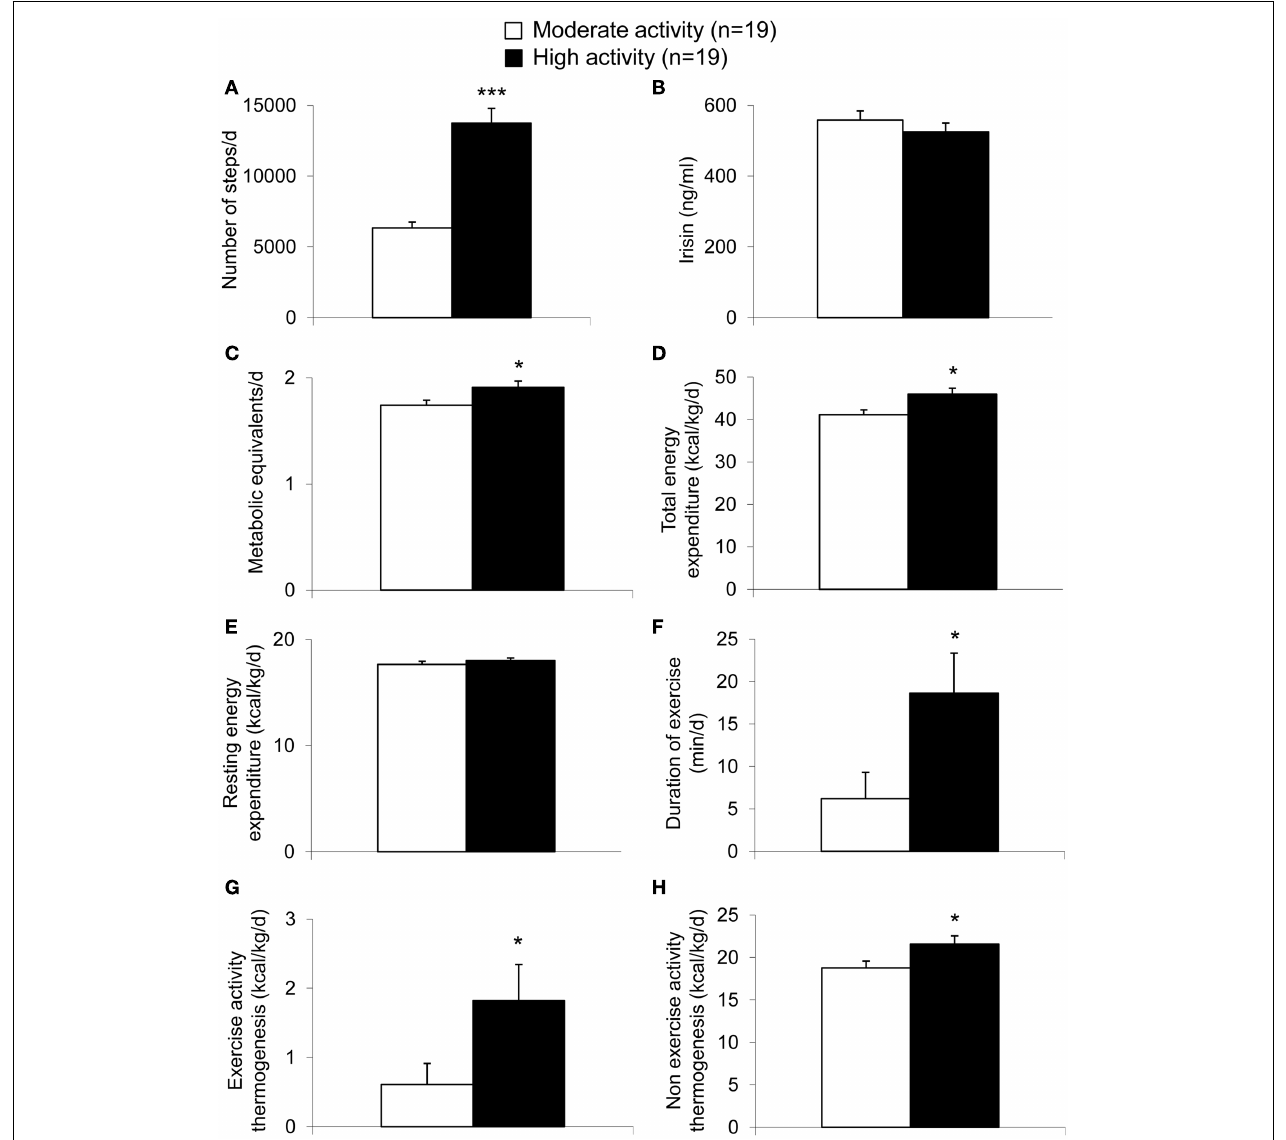
group, while no differences were observed for body weight-adjusted resting energy expenditure (E) . Duration of exercise (F) , body weight-adjusted exercise activity thermogenesis (G) , and body weight-adjusted non-exercise activity thermogenesis (H) were higher in the high compared to the moderate activity group. Data are expressed as mean ± SEM. * p < 0.05, ** p < 0.01, and *** p < 0.001 in the high vs. moderate activity group ( n =